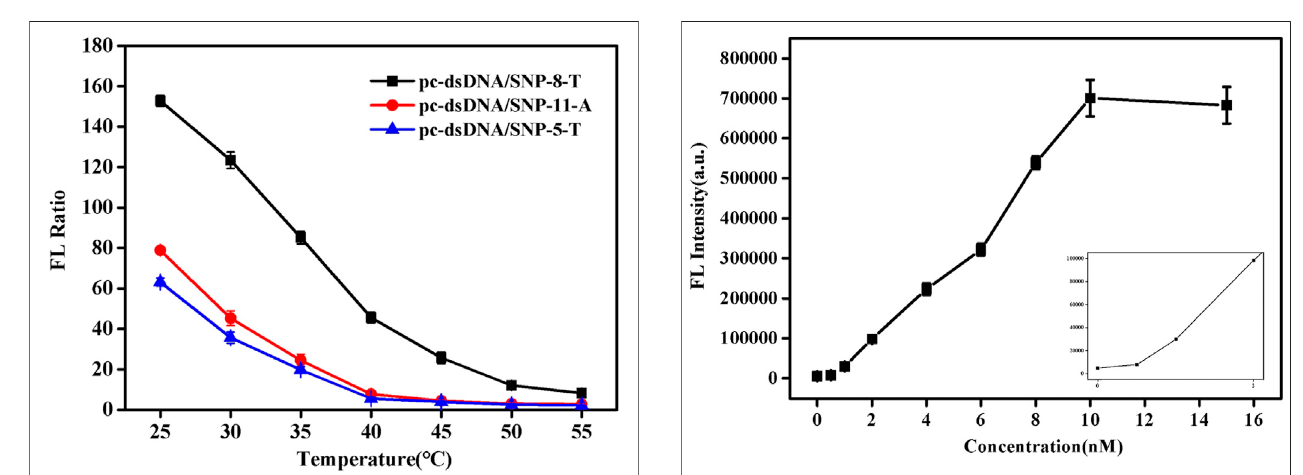
FIGURE 3 | Emission spectra of with varying pc-dsDNA/SNP-5-T, pc- dsDNA/SNP-8-T and pc-dsDNA/SNP-11-A ratios at different temperatures (25, 30, 35, 40, 45, 50, and 55 ° C). The fi nal concentration: [SNPs] (cid:2) 10 nM, [pc-dsDNA] (cid:2) 10 nM, [GO] (cid:2) 2.5 μ g/ml, 10 mM phosphate buffer (20 mM NaCl, pH 7.4). Error bars represented the SD of fi ve experiments.